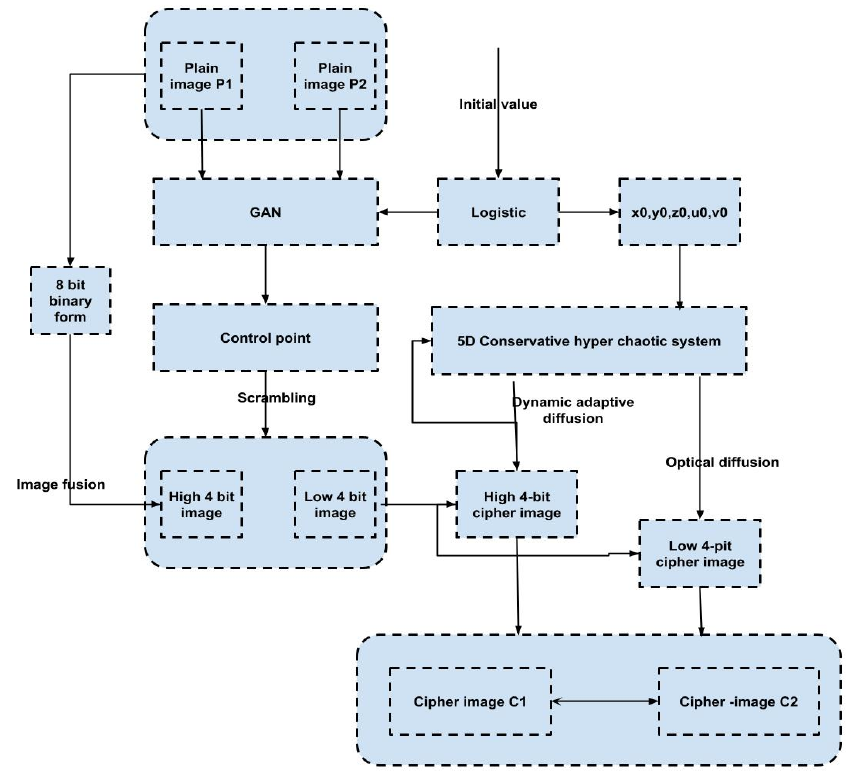
Figure 4. Flowchart of the encryption algorithm.